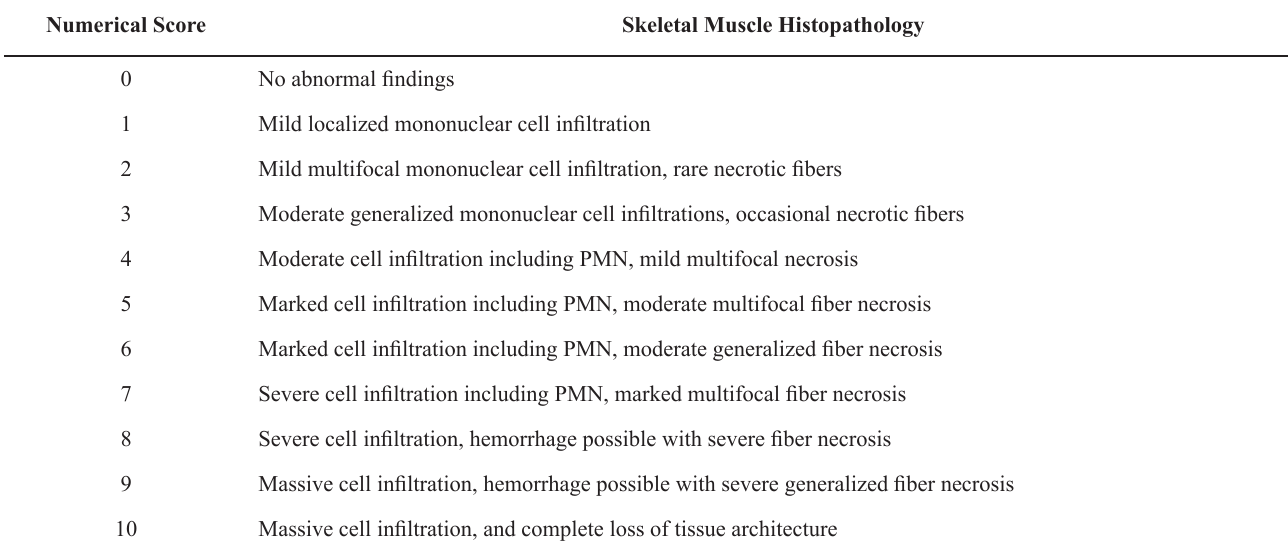
Table 1- Histopathology scoring system Numerical